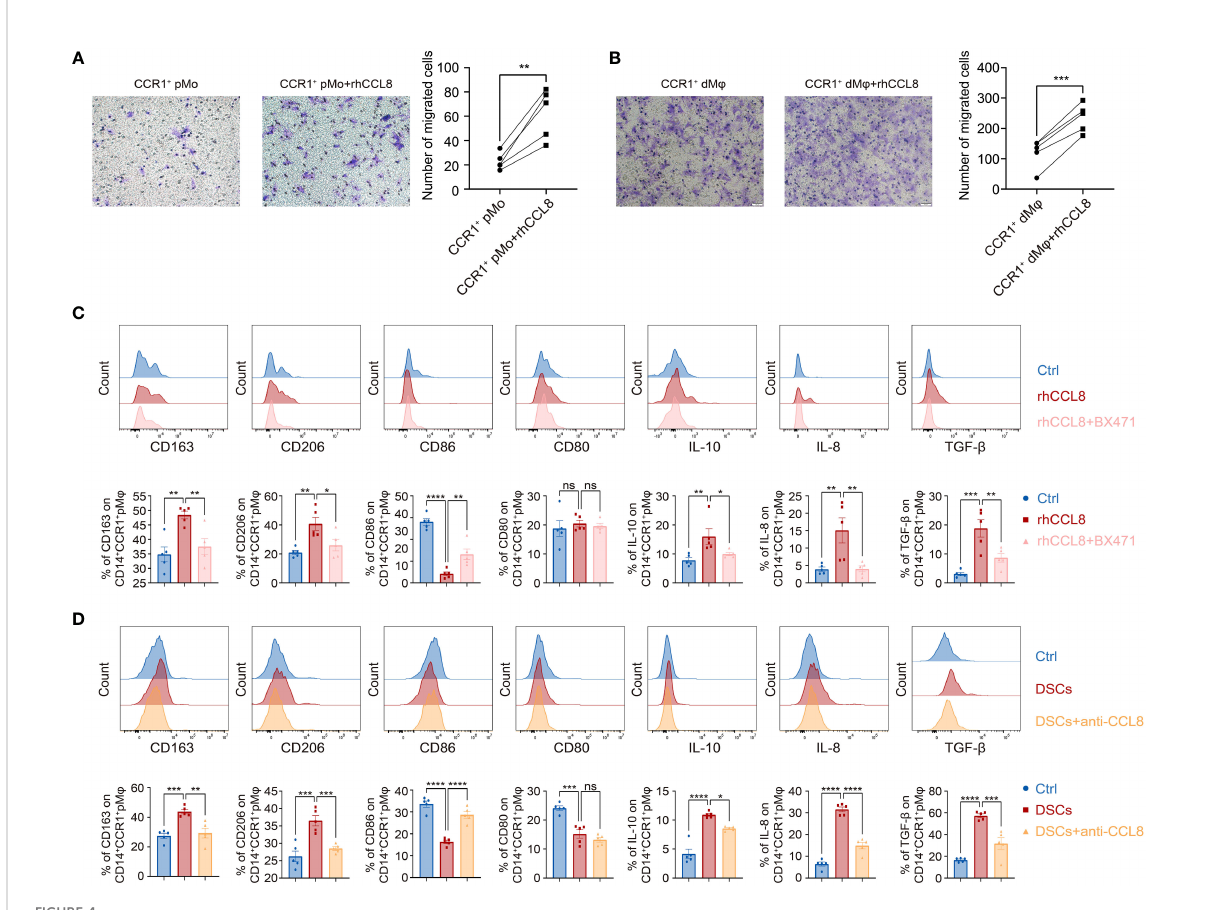
FIGURE 4 DSC-derived CCL8 recruits and educates CCR1 + pM j towards CCR1 + dM j phenotype. (A, B) Representative images and quanti fi cation of migration of the CCR1 + pMo (n=5 per group) (A) and dM j (n=5 per group) (B) stimulated by rhCCL8. (C) Representative plots and quanti fi cation of the membrane molecules and cytokines in CCR1 + pM j treated with rhCCL8 in the presence or absence of the CCR1 inhibitor, BX471 (n=5 per group). (D) Flow cytometric analysis and quanti fi cation of the indicated membrane molecules and cytokines in CCR1 + pM j co-cultured with DSCs in the presence or absence of the CCL8 neutralizing antibody (n=5 per group). Data are presented as mean ± SEM. and are representative of at least two separate experiments. ns, not signi fi cant; *p < 0.05, **p < 0.01, ***p < 0.001, ****p <